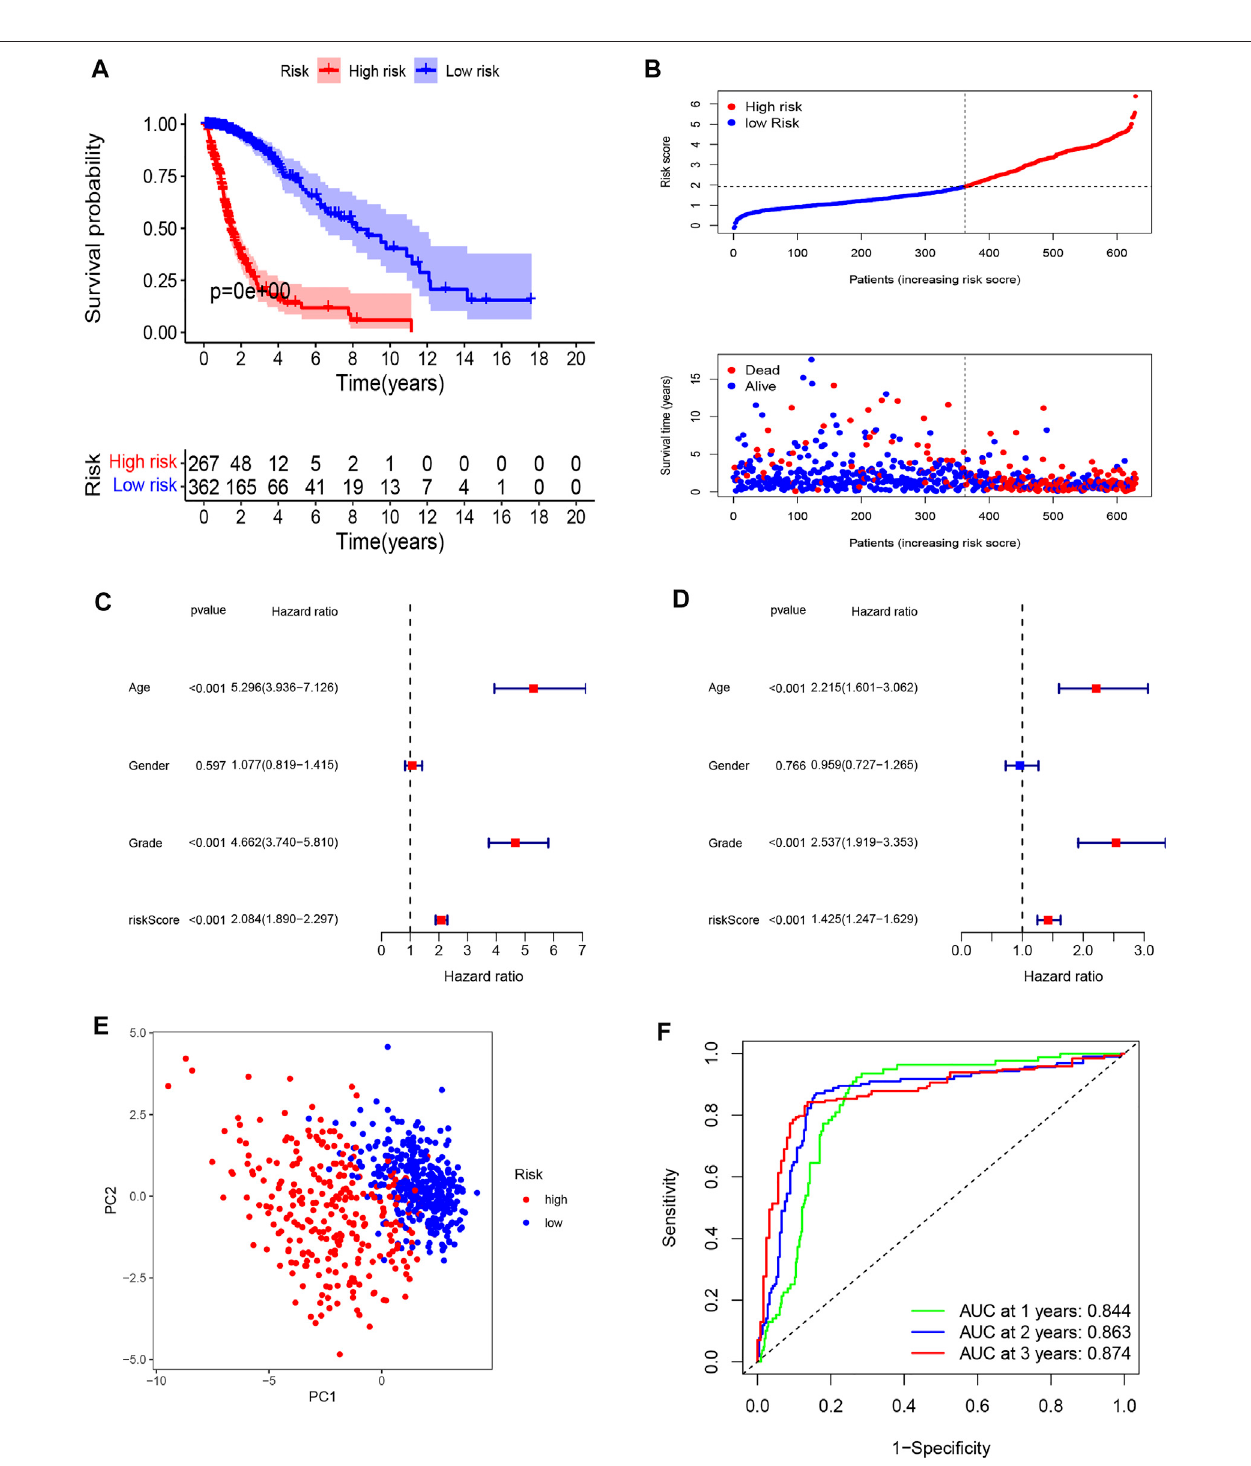
FIGURE 4 | External validation of a pyroptosis-related gene prognostic signature in the TCGA cohort. (A) Kaplan-Meier curves for OS of patients in high- and low- riskgroupinTCGACohort. (B) DistributionofriskscoreofallpatientsofTCGAcohortandPatients ’ survivaltimedistributionofTCGAcohort. (C) Forestplotofunivariate cox regression between risk scoreand prognosisofglioma in TCGA cohort. (D) Forest plot of multivariate coxregression of between riskscore and prognosis ofglioma in TCGA cohort. (E) PCA plot for signature genes based on risk score group in TCGA cohort. (F) ROC curves showed the predictive ef fi ciency of risk score at 1- year, 2-years, 3-years point in TCGA cohort.